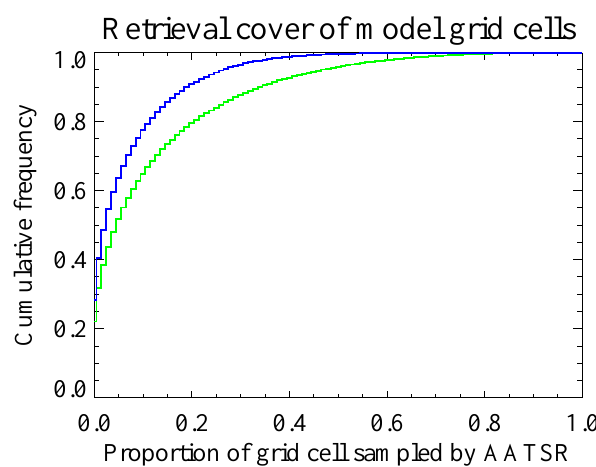
Fig. 5. Cumulative frequency distribution of, for those GEOS- Chem daily grid cells containing AATSR aerosol retrievals, the pro- portion p of the area of the grid cells filled by the retrievals. The green line is for land grid cells, and the blue line